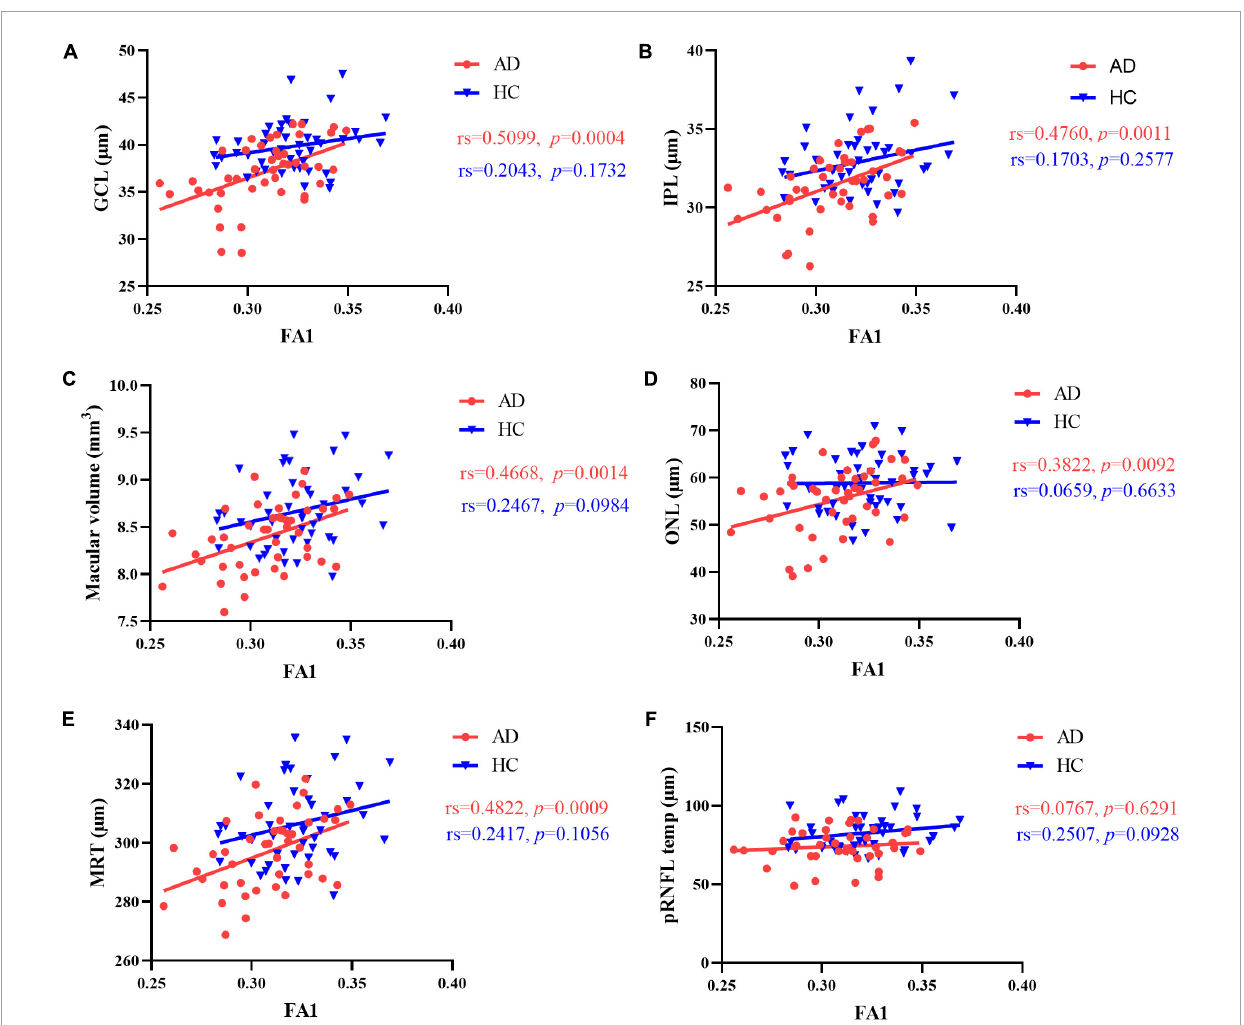
FIGURE3 Correlation between FA value of optic tract and retinal thickness. In AD patients, there was a significant positive correlation between FA value of optic tract and (A) GCL thickness, (B) IPL thickness, (C) macular volume, (D) ONL thickness and (E) mean retinal thickness. (F) No correlation was found between FA value of optic tract and temporal quadrant pRNFL thickness. There was no correlation between FA value of optic tract and retinal thickness in HCs. MRT, mean retinal thickness; GCL, ganglion cell layer; IPL, inner plexiform layer; ONL, outer nuclear layer; pRNFL, peripapillary retinal nerve fiber layer; FA1, fractional anisotropy of the optic